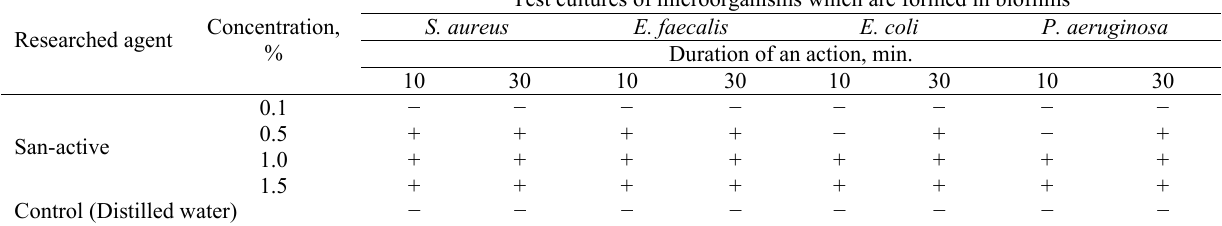
Influence of “San-active” on conditional pathogenic microorganisms that are formed in a biofilm at a temperature of 60 ± 5 °С, n = 20 Test cultures of microorganisms which are formed in biofilms Concentration, Researched agent